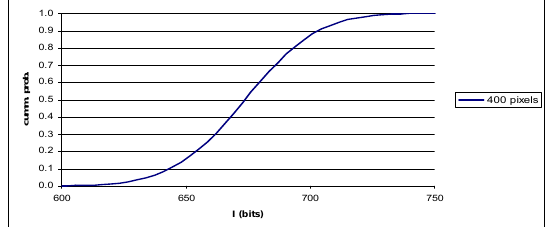
Figure 5. Mutual information distribution for 400 pixels not available for this research. A portion of one of the images is shown in Figure 6 (left). The exterior and interior orientation parameters were obtained by incorporating scene constraints in the triangulation of oblique images (Gerke, 2011). The RMSE at check points in object space was around 20 cm in x, y and z components after the self-calibration bundle adjustment. A point cloud was also obtained by matching in the oblique images (Furukawa and Ponce, 2010). Figure 6 (right) shows a portion of the point cloud overlaid with building models.